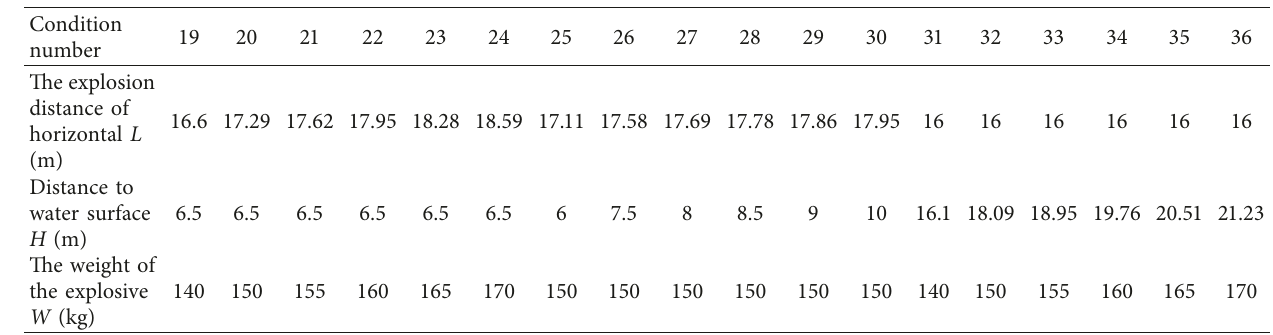
Table 5: The port condition parameters under the same shock